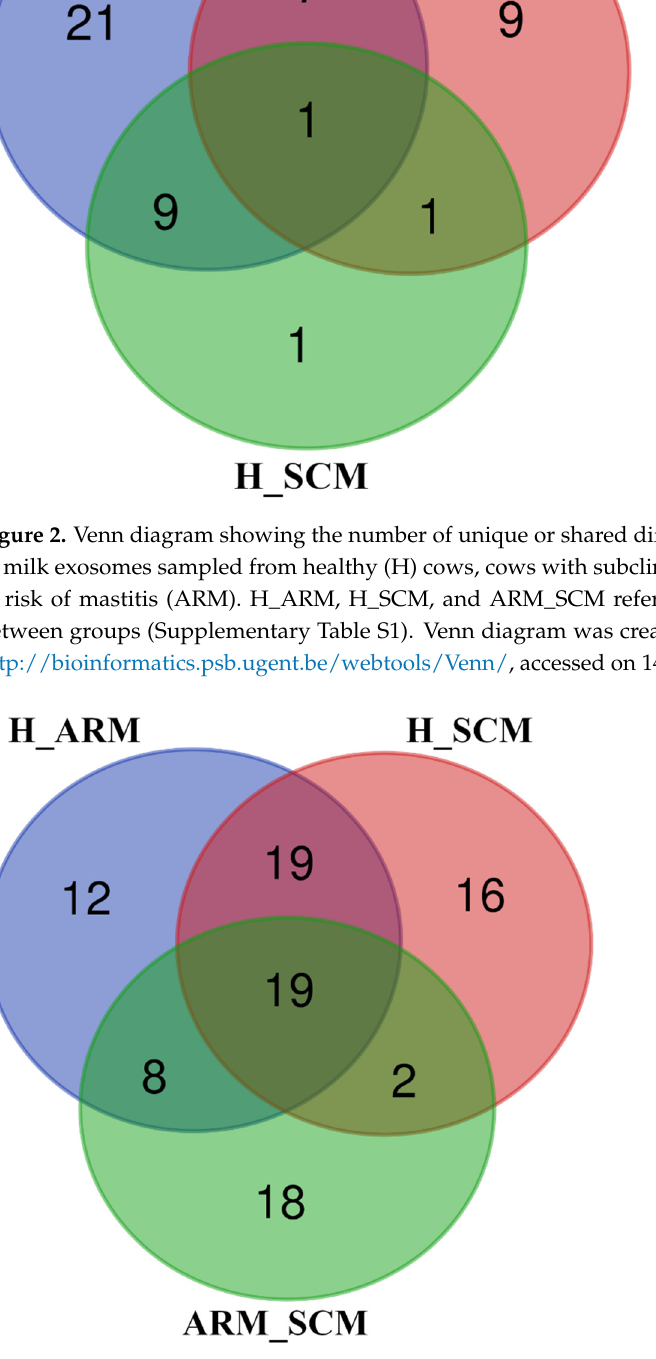
Figure 3. Venn diagram showing the number of unique or shared KEGG pathways of the target genes significantly enriched in the comparisons between healthy (H) cows, cows with subclinical mastitis (SCM), and cows at risk of mastitis (ARM). H_ARM, H_SCM, and ARM_SCM refer to the pairwise comparisons between groups (Supplementary Table S3). Venn diagram was created by a web tool available at http://bioinformatics.psb.ugent.be/webtools/Venn/, accessed on 14 December 2022.